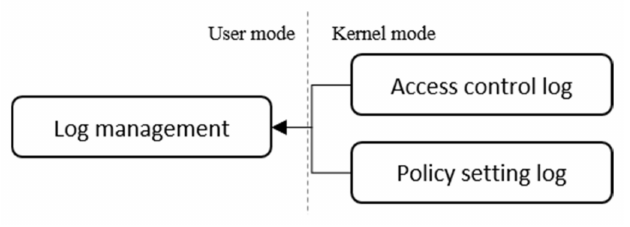
Figure 12. Log management configuration of the proposed system.